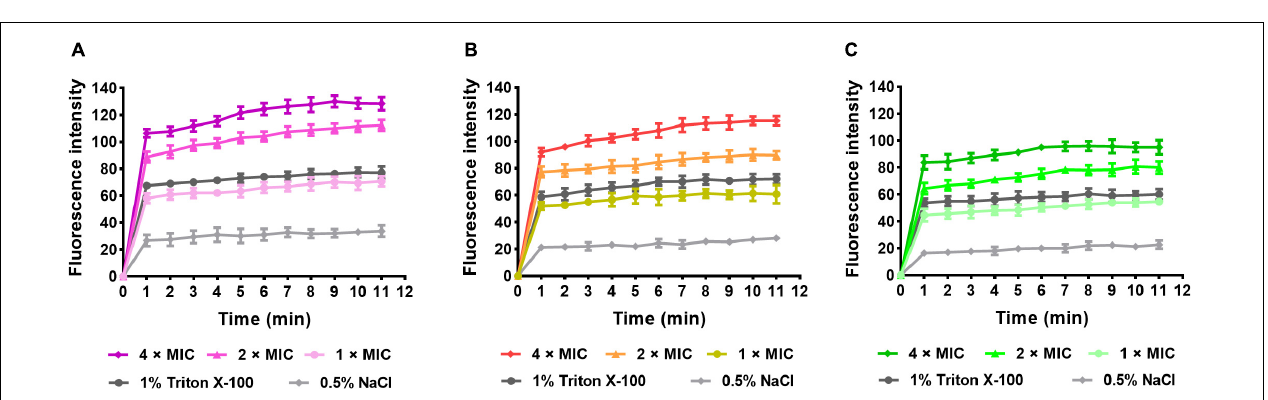
FIGURE 7 | Absorbance curve at 420 nm of ONPG hydrolyzed by β -galactosidase. (A) E. coli (CMCC44103) was treated with S1, (B) E. coli (SYPB-3820) was treated with S2.